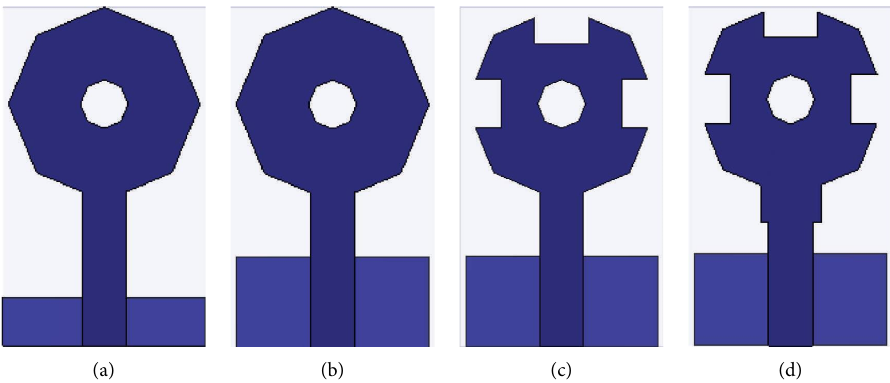
Figure 2: Development stages of the antenna: (a) evolution 1, (b) evolution 2, (c) evolution 3, and (d) evolution 4.